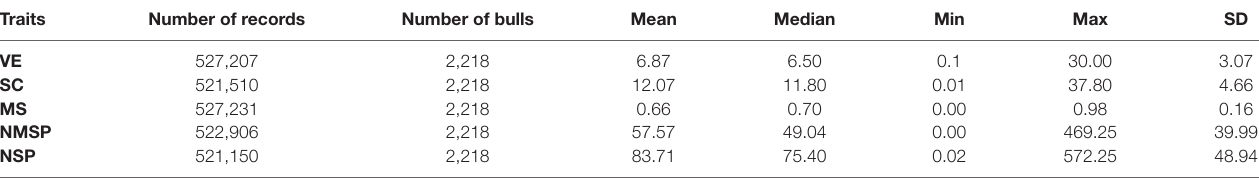
TABle 1 | Descriptive statistics of five semen traits.